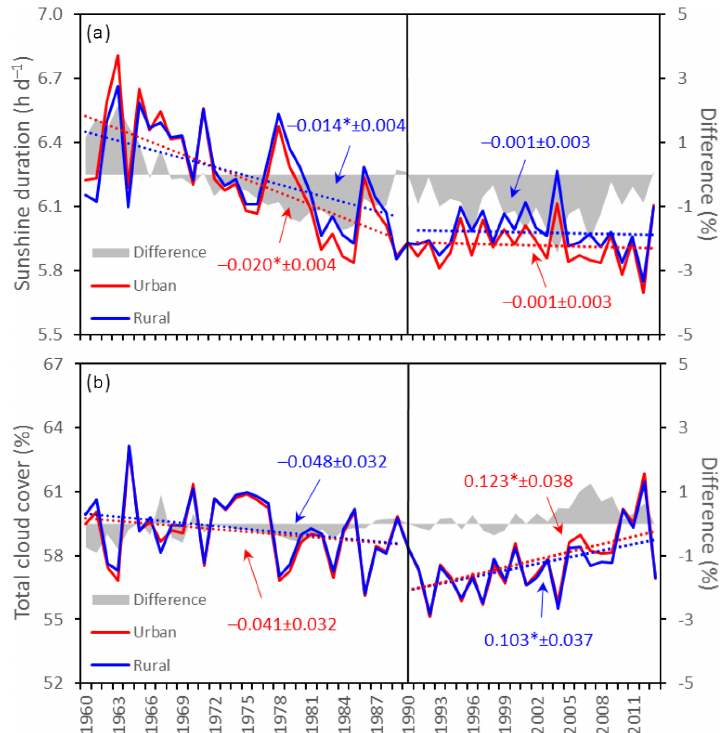
Figure 4. Comparisons of annual trends in average daily sunshine duration (hd − 1 ; a ) and total cloud cover (%; b ) between urban and rural areas and the differences (%) for the dimming (1960–1989) and leveling-off (1990–2013) phases in China. The values indicate the trend slopes and corresponding standard errors. Significant trends at the 95% confidence level are indicated with a